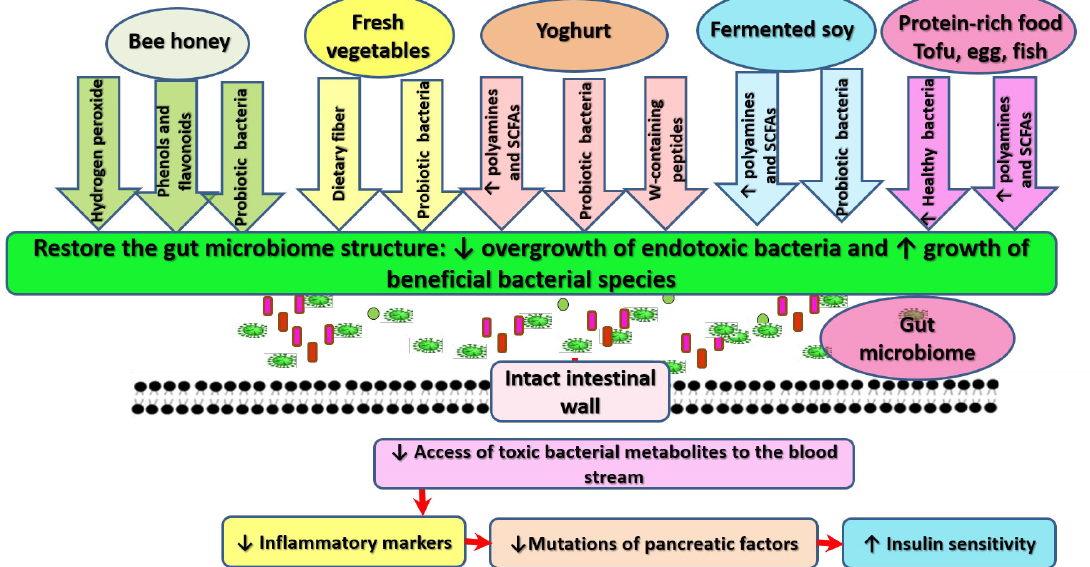
Figure 5. Possible mechanisms through which foods consumed by the patient can promote the gut microbiome and decrease insulin resistance. The dietary pattern adopted in this case may operate through various means to positively alter gut microbiome structure, inhibit intestinal wall leakage, and prevent associated inflammatory response, which may o ff er protection for pancreatic islets against